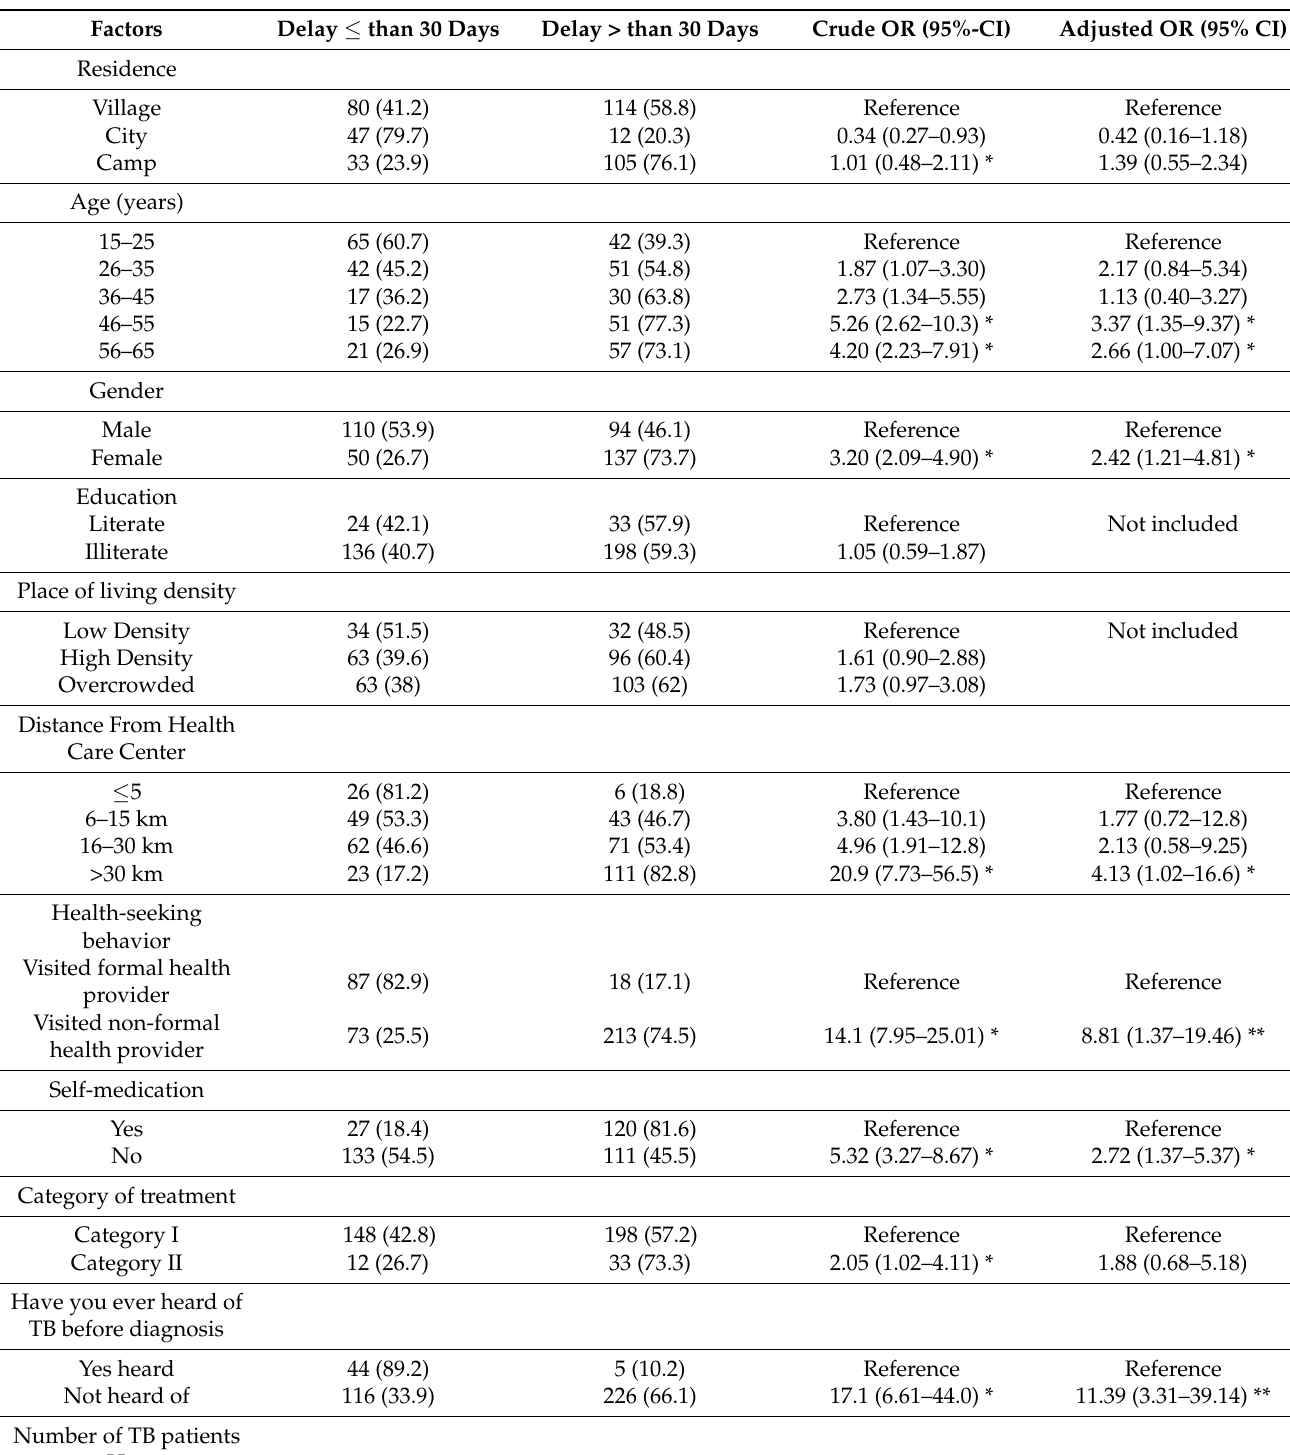
Table 3. Logistic Regression analysis of factors associated with prolonged delay in treatment IDPs Predicted probability is